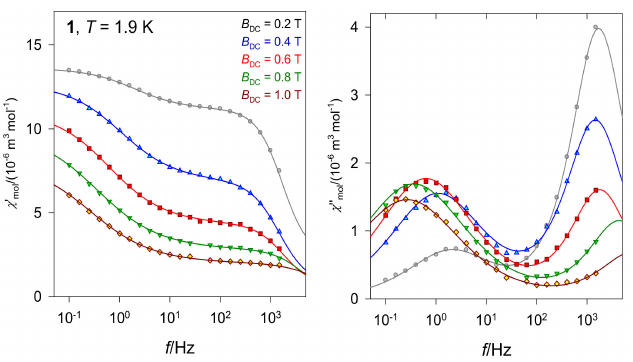
Figure 6. AC susceptibility data for 1 : frequency dependence for a set of the external fields at T = 1.9 K. Solid lines—fitted with a two-set Debye model. The AC susceptibility data (22 points for χ (cid:48) and 22 points for χ ”) have been subjected